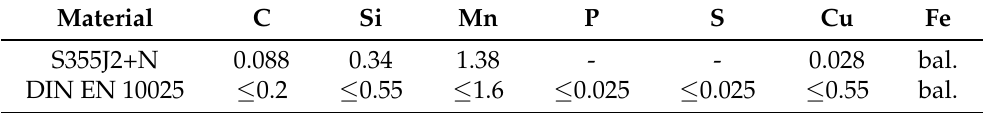
Table 1. Standardized and measured chemical composition of the material used in